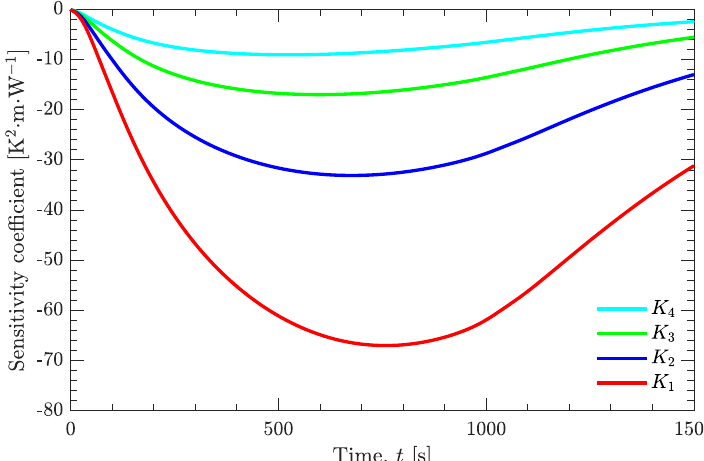
Figure 11. Sensitivity coefficient of the unknown parameters to be